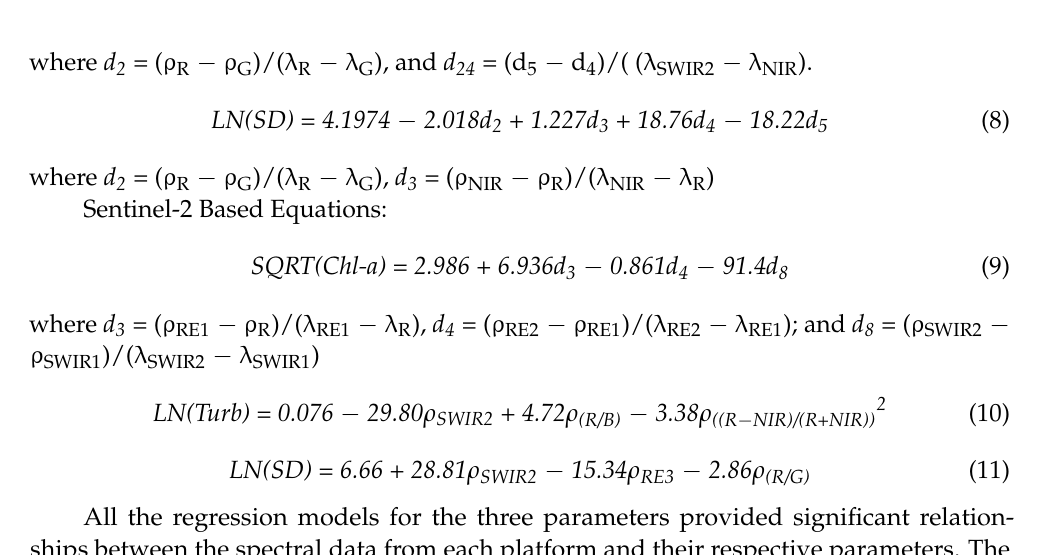
Table 4. Statistics of the best fit regression models for PS, Landsat-8 (L8), and Sentinel-2 (S2). R 2 RMSE Maximum VIF Parameter PS L8 S2 PS L8 S2 PS L8 S2 Chl-a 0.58 0.75 0.85 4.41 µ g/L 2.04 µ g/L 1.19 µ g/L 1.20 2.74 Turb 0.79 SD